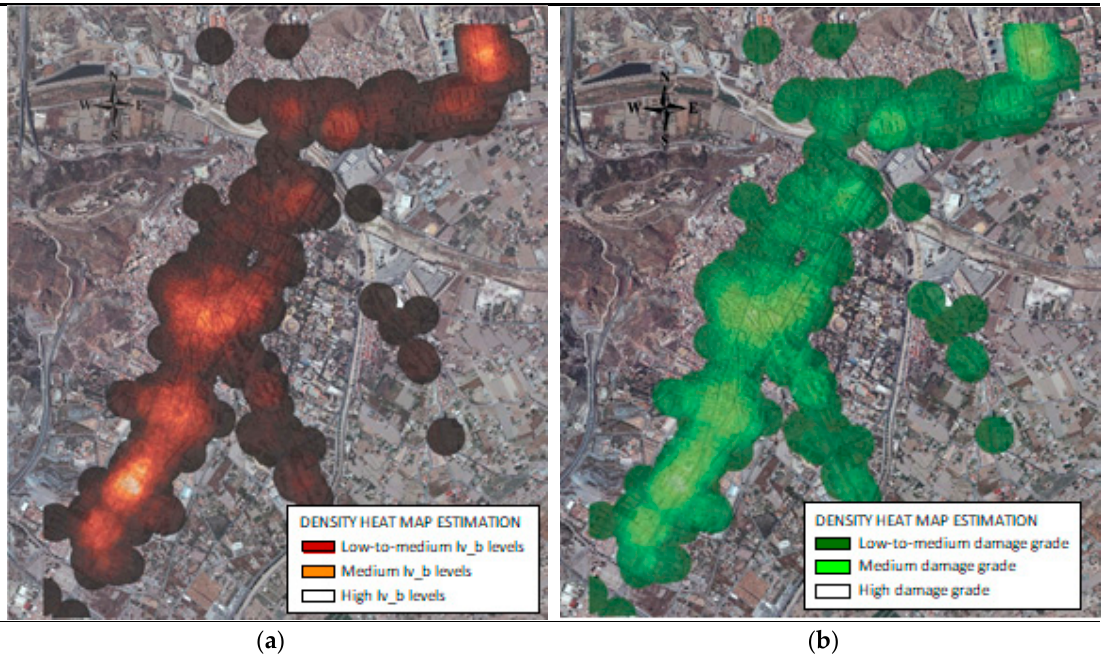
Figure 6. ( a ) GIS plotting of density estimation for the vulnerability indexes Iv b of RC buildings evaluated in the city of Lorca, obtained according to the proposed model of the LM1 method. ( b ) GIS plotting of density estimation for the mean damage grades according to the new proposal for an I EMS -98 = VII earthquake.